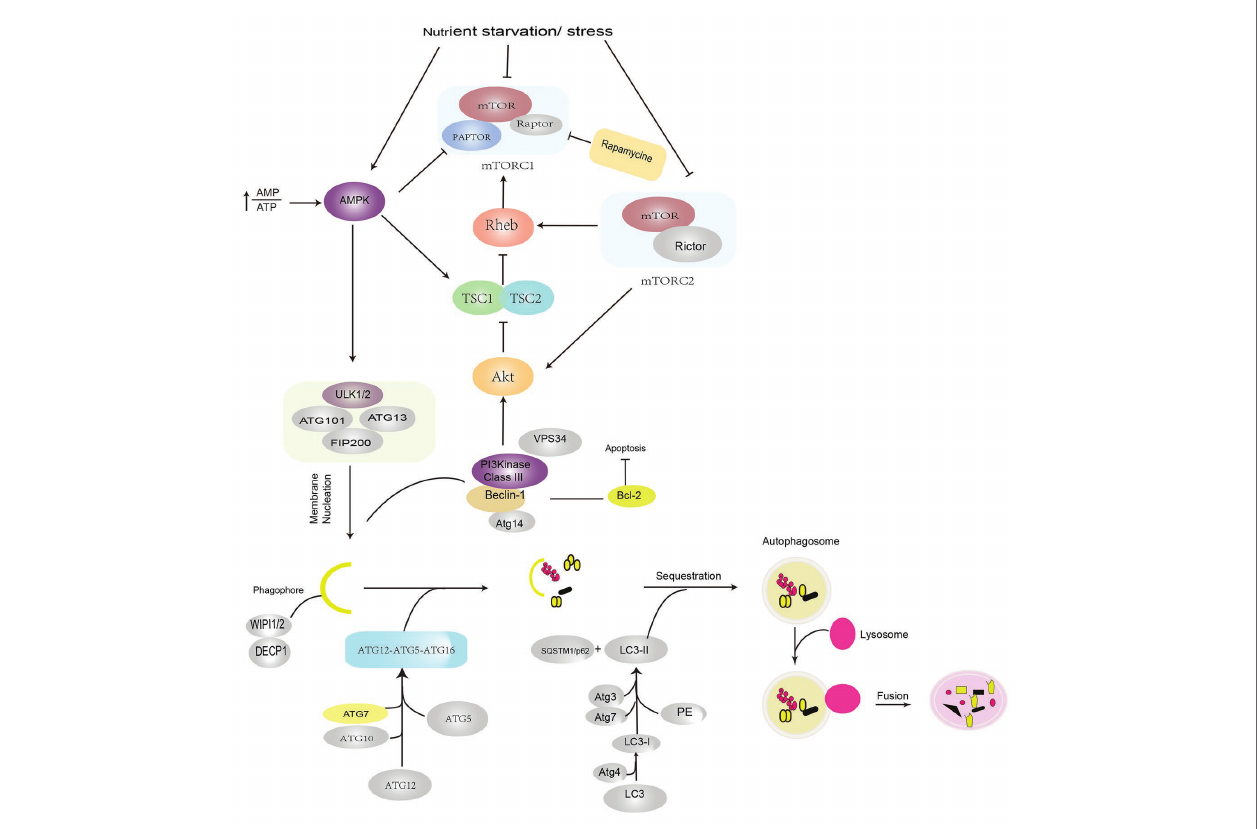
FIGURE 1 | Induction and signaling pathways in autophagy. Autophagy is induced under conditions of nutrient starvation and stress by the activation of AMPK and suppression of the mTOR pathways. The initiation of autophagy is regulated by ULK1/2 complex phosphorylation of the VPS34–Beclin-1 complex, which leads to the recruitment of the cellular PI3P effector proteins DECP1 and WIPI 1/2 and contributes to the formation of an isolated membrane. Autophagosome formation requires the participation of two ubiquitin-like conjugation systems: the ATG12–ATG5–ATG16 complex, which promotes phagophore extension, and LC3/PE, which promotes phagophore closure. After autophagosomes are formed, they fuse with lysosomes and degrade the contents. AMPK: AMP-activated protein kinase; PI3P: phosphatidylinositol-3-phosphate; DECP1: protein 1 containing zinc finger FYVE domain; WIPI 1/2: WD-repeat domain phosphoinositide interaction protein; LC3: light chain 3; VPS34: vacuolar protein sorting 34; PE: phosphatidylethanolamine; ULK1: Unc-51-like kinase